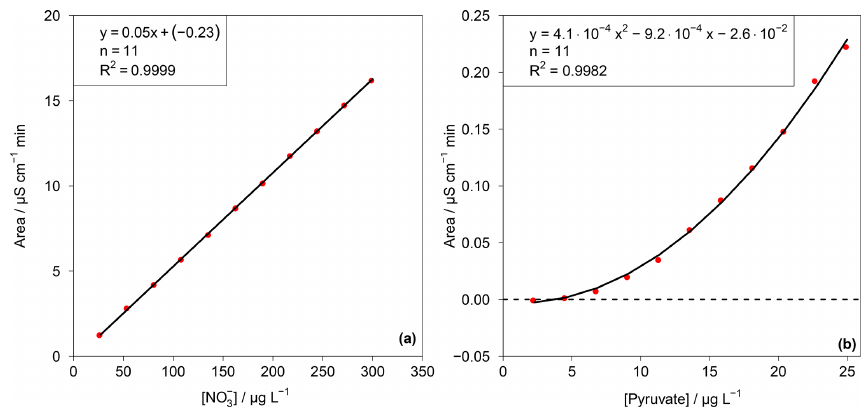
Figure 6. (a) Linear (NO − ) and (b) quadratic (pyruvate) calibration functions. 3